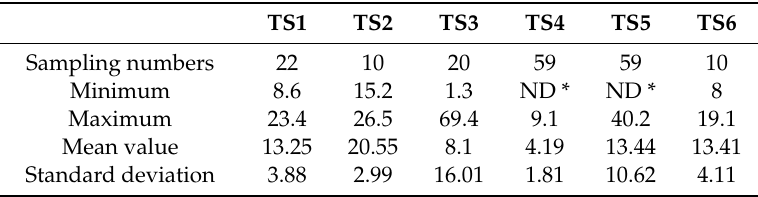
Table 3. The content of total mercury (THg) content ( µ g · kg − 1